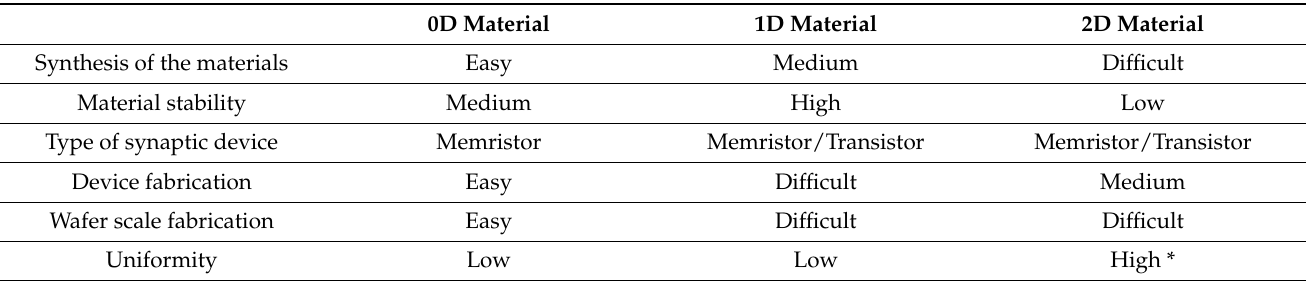
Table 1. Summary of the advantages and disadvantages of low-dimensional materials in the applications of flexible artificial synapses .